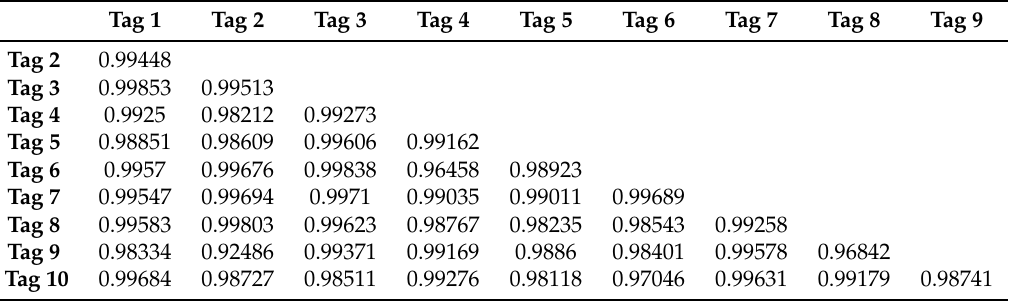
Table 5. Correlation among different instances of RFID tags - Relative Humidity (%).